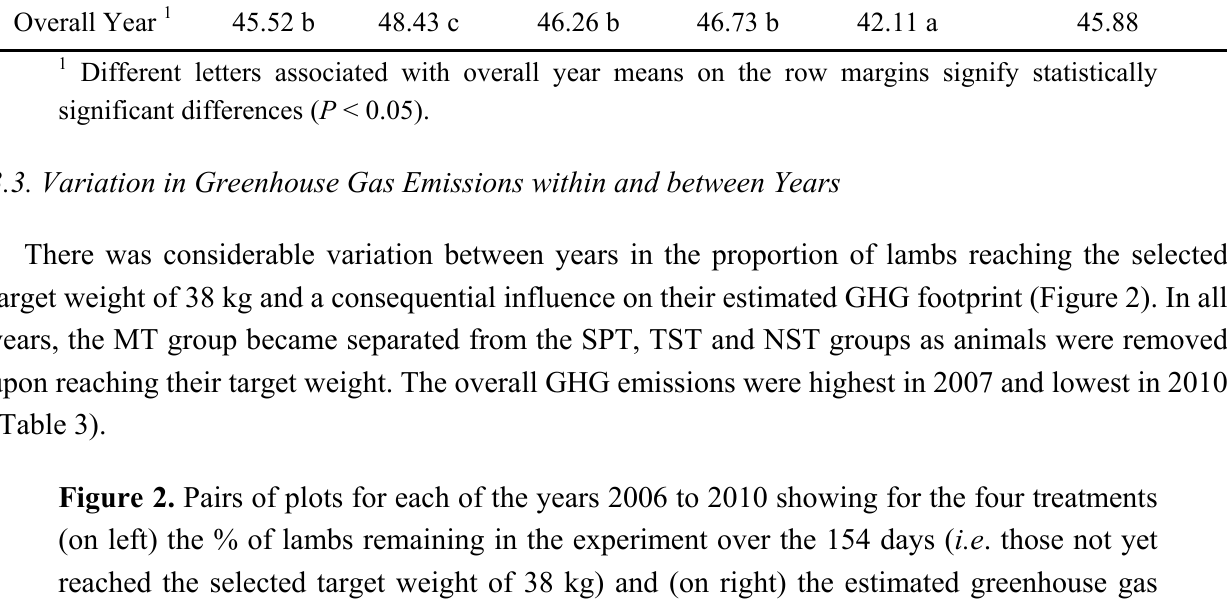
e per lamb) assuming 2